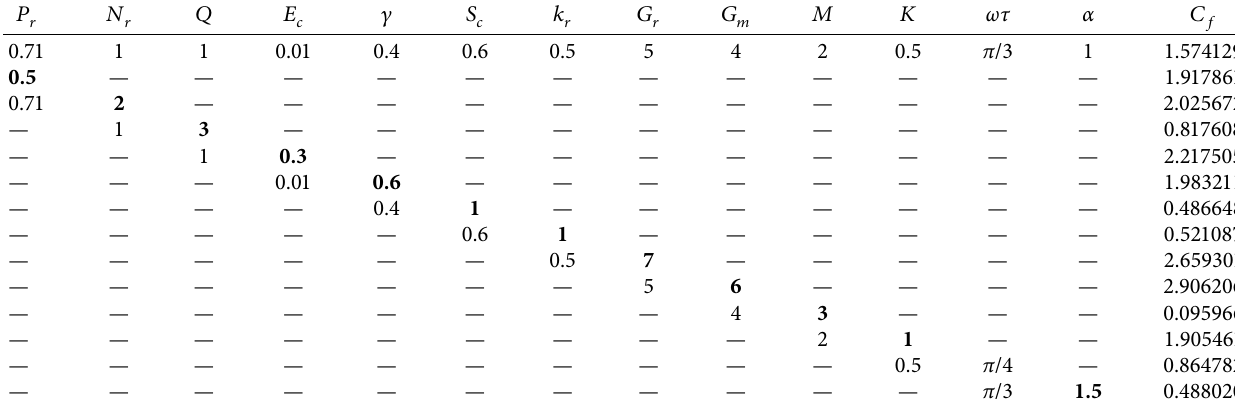
Table 3: Variation of the Nusselt number N